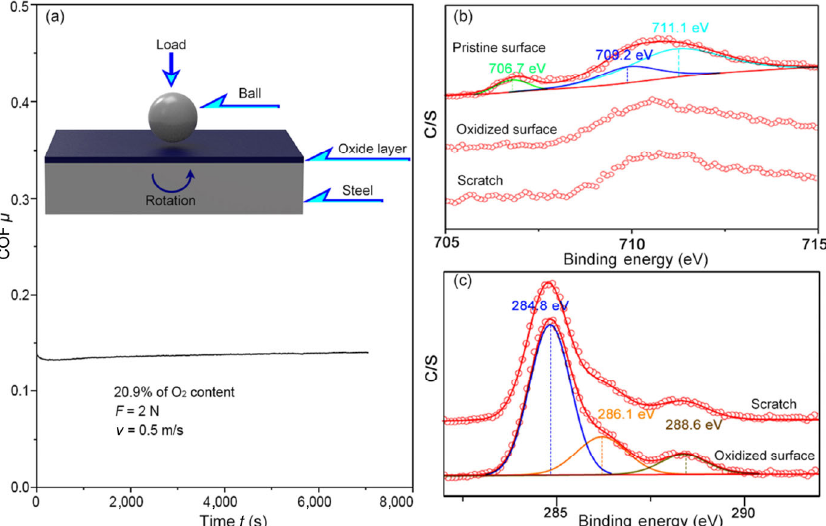
Fig. 9 (a) Friction behavior on the pre-oxidized steel surface against steel ball with diketone lubrication under ~20.9 wt% O 2 environment. The inset in (a) shows the diagram of friction test between the steel ball and pre-oxidized steel substrate lubricated with EPBD-0201 solution. (b) Fe 2p components measured at the pristine steel surface, pre-oxidized steel surface, and inside the wear track on the pre-oxidized steel surface. (c) Comparison of C 1s spectra measured at the pre-oxidized steel surface and inside a wear